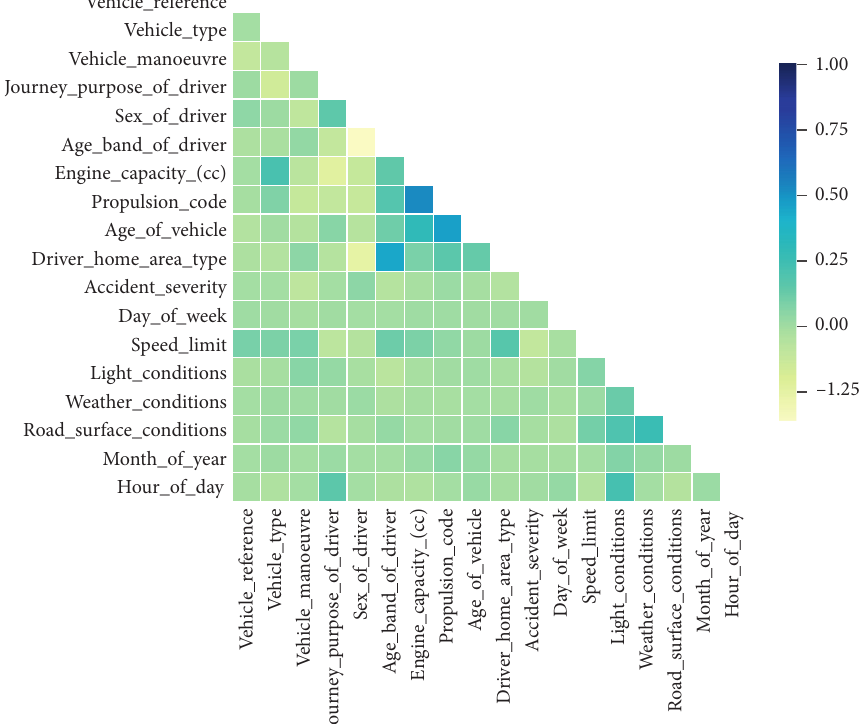
Figure 6: The Pearson correlation matrix of all